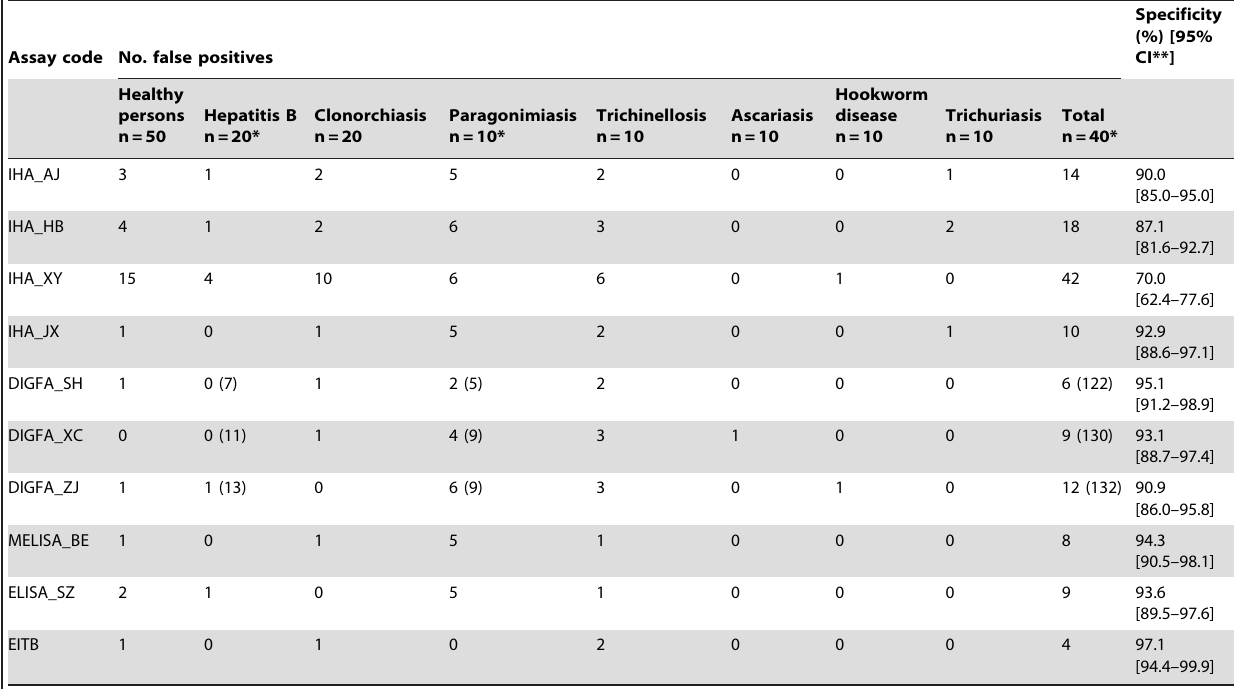
Table 3. False positive results of the evaluated immunoassays.